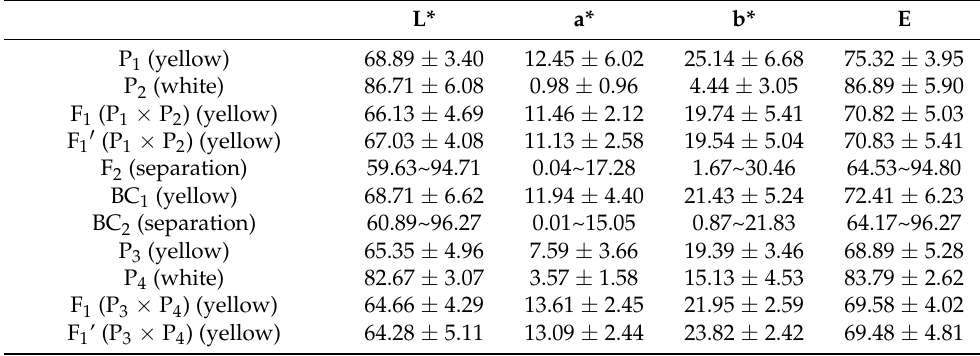
Table 1. Seed coat color values of parents and segregating populations obtained by